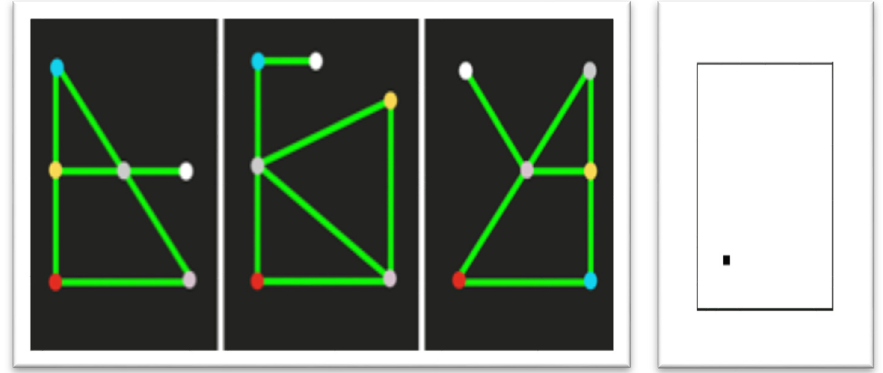
Figure 5. Experimental maps rendered on the Samsung Galaxy Tab3 Android tablet ( left ), a canvas for the reconstruction task with start location ( right ).